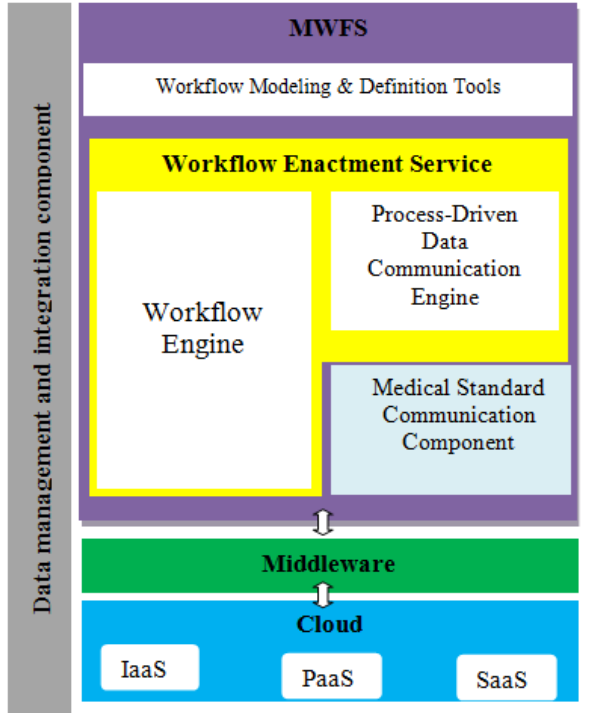
Fig. 1. Cloud-based medical workflow system